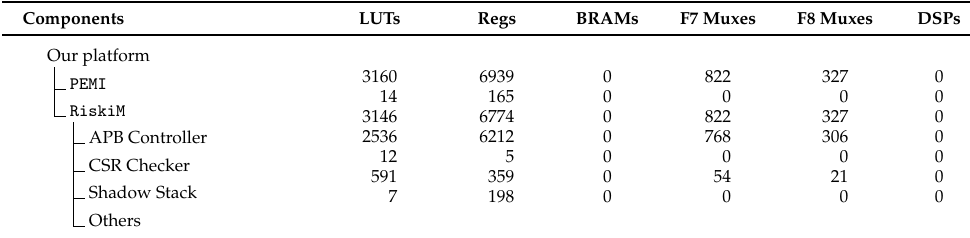
Table 2. FPGA utilization report of our